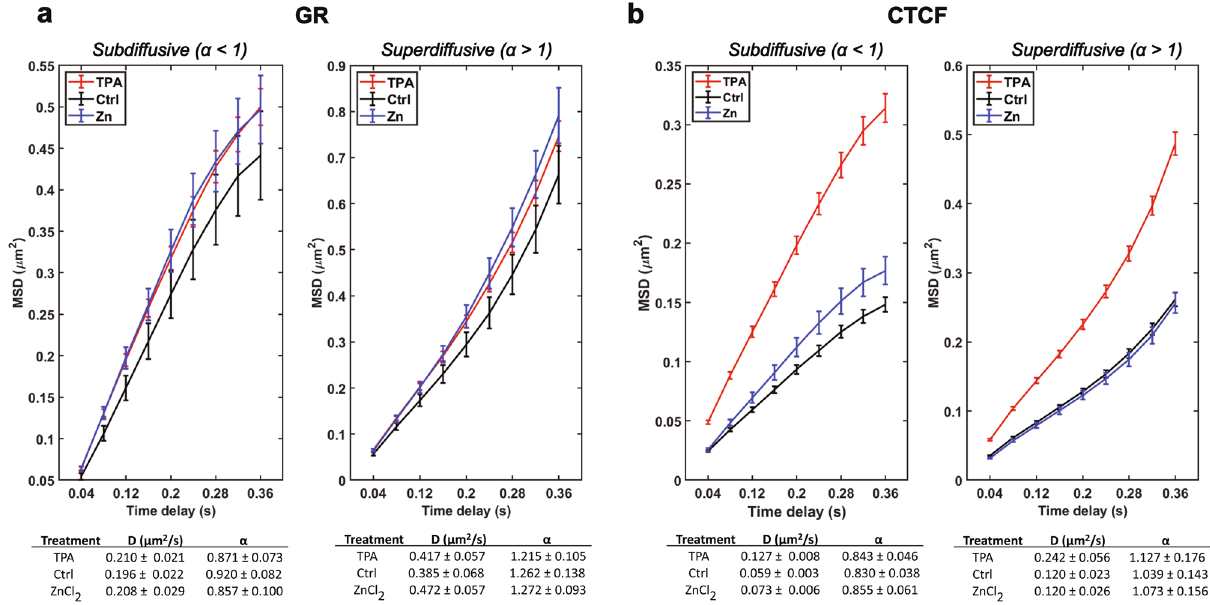
Figure 3. The effect of Zn 2+ on subdiffusive and superdiffusive populations of HaloTag-GR or HaloTag-CTCF. ( a ) Subdiffusive and superdiffusive populations of HaloTag-GR expressing cells, treated with 50 µM TPA, 30 µM ZnCl 2 , or a media-only control. Lines indicate the respective population’s mean MSD at a given time delay, and error bars represent the standard error of the mean. Total number of superdiffusive trajectories: TPA, 653; Ctrl, 183; ZnCl 2 : 285. Total number of superdiffusive trajectories: TPA, 750; Ctrl, 236; ZnCl 2 : 316. ( b ) Same as in ( a ), but for cells expressing HaloTag-CTCF. Total number of superdiffusive trajectories: TPA, 2258; Ctrl, 2531; ZnCl 2 : 964. Total number of superdiffusive trajectories: TPA, 2788; Ctrl, 2454; ZnCl 2 :